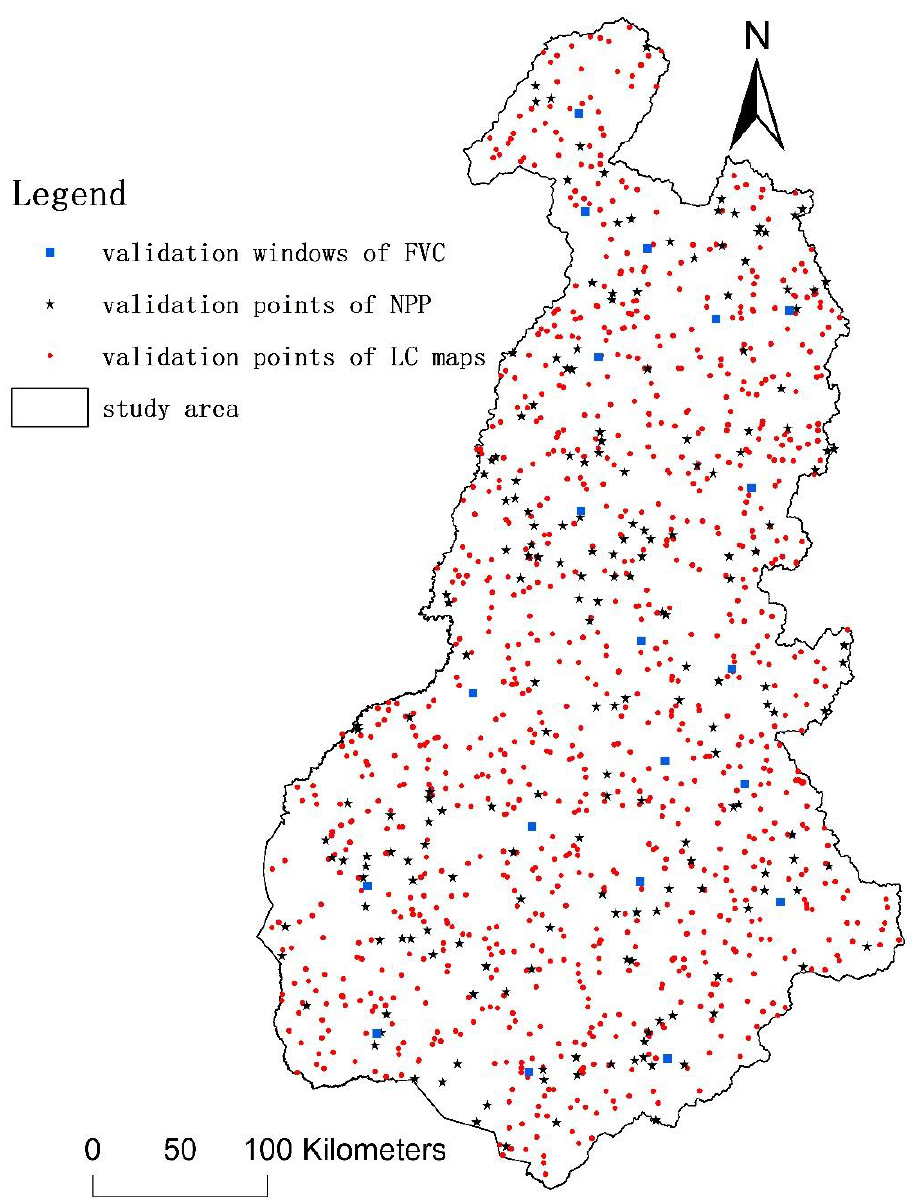
Figure 4. Validation points for the land cover classification maps and NPP and the validation win- dows for the FVC.